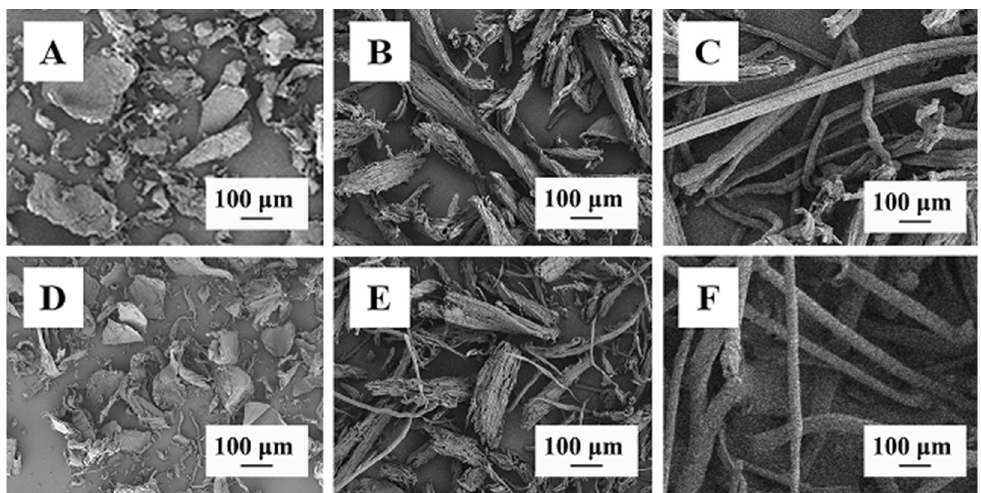
Figure 2. The microstructure BC ( A ), Cellulose ‐ H ( B ), Cellulose ‐ B ( C ), CMBC ( D ), CMC ‐ C ( E ), and CMC ‐ B ( F ).